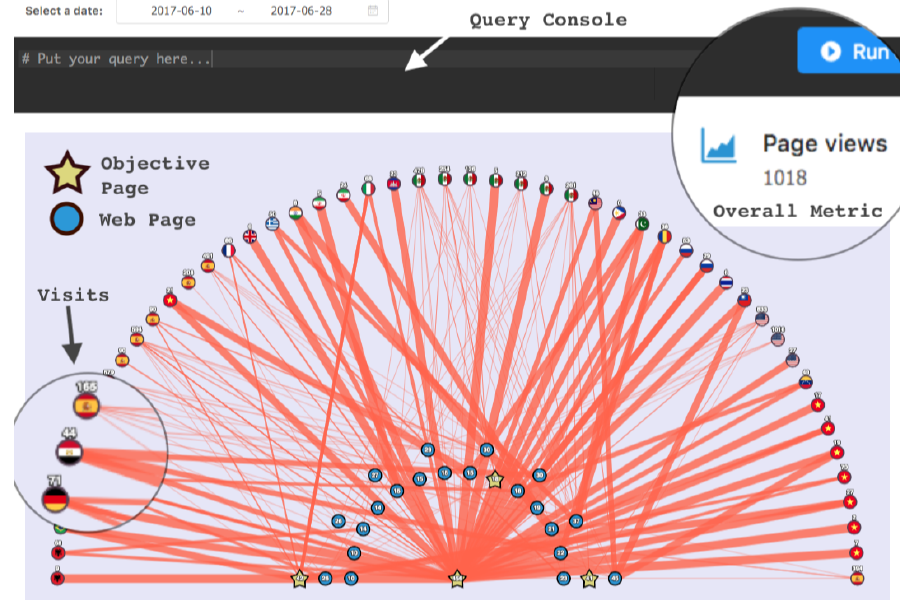
Figure 4. Visits View. Blue nodes represent web pages; stars are objective pages; nodes with country flags are visits of users from that country. Page views was used as metric and inverse visit duration for the edge width. Thin connections represent longer visit duration; thicker